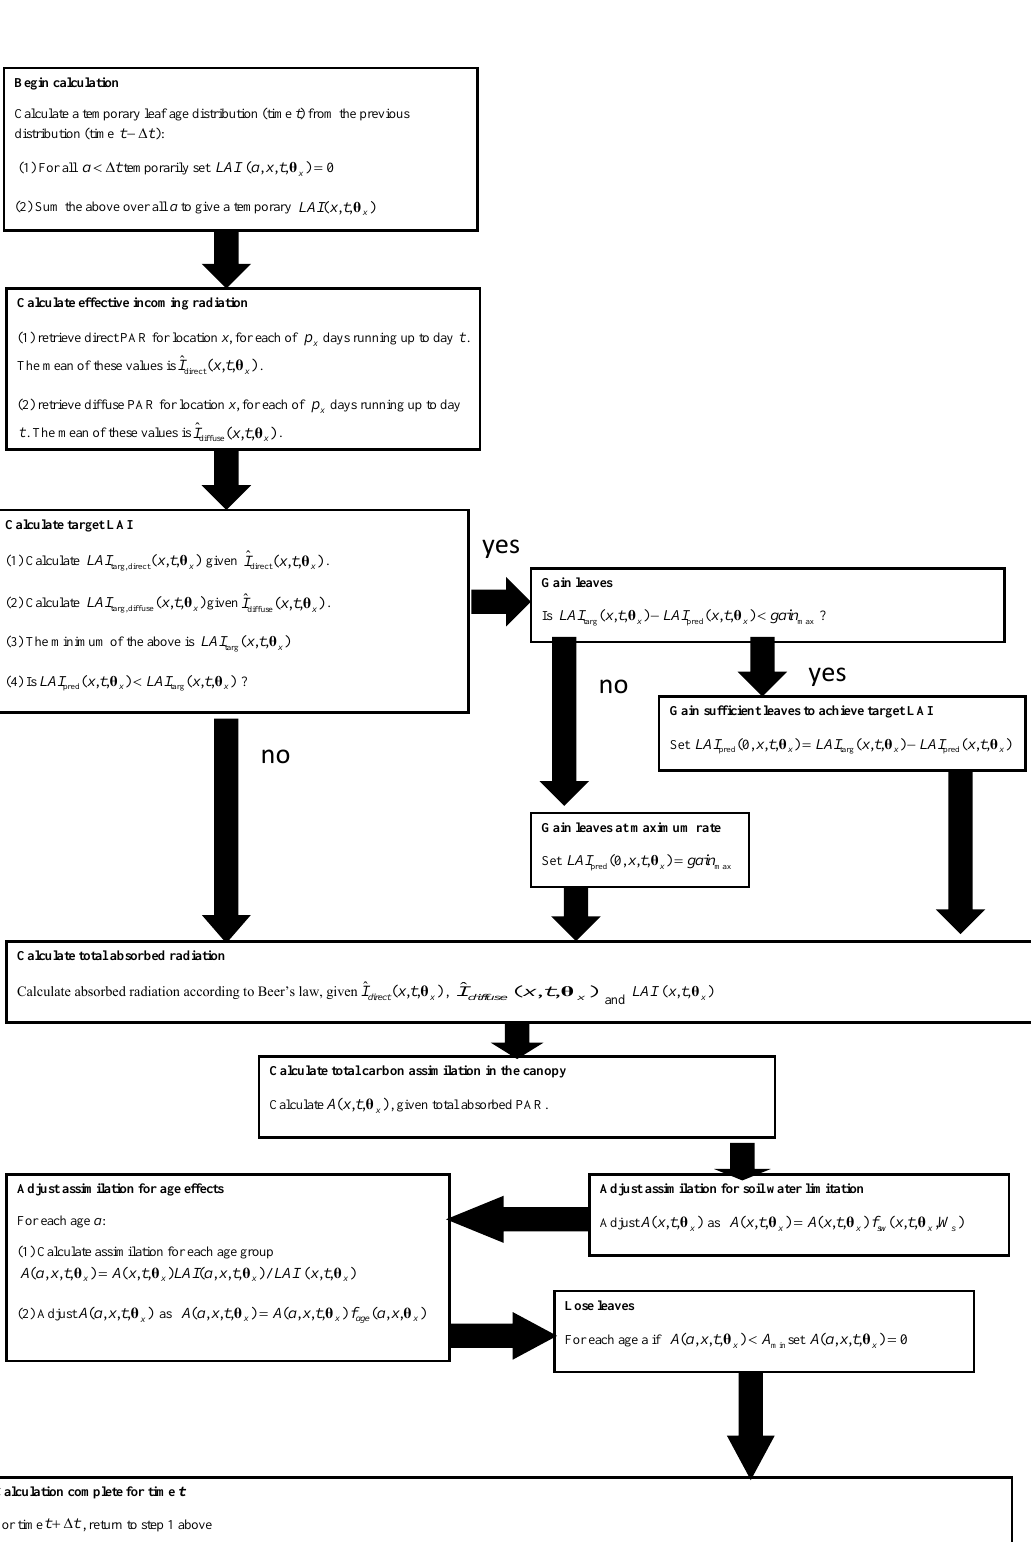
Biogeosciences, 11, 763–778,